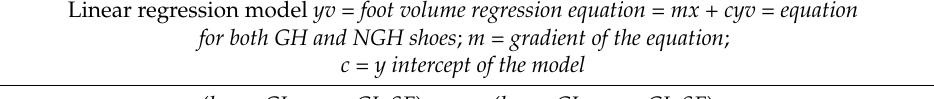
Table 3. Linear Regression—Statistical Analysis for Foot Volume and Capacitance.